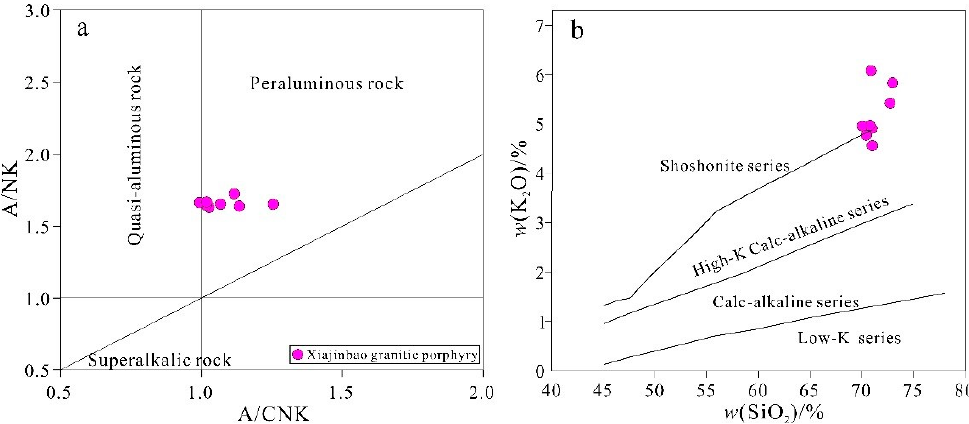
Figure 6. SiO 2 versus K 2 O ( a ) and A/NK versus A/CNK ( b ) diagrams for the Xiajinbao granitic porphyry.